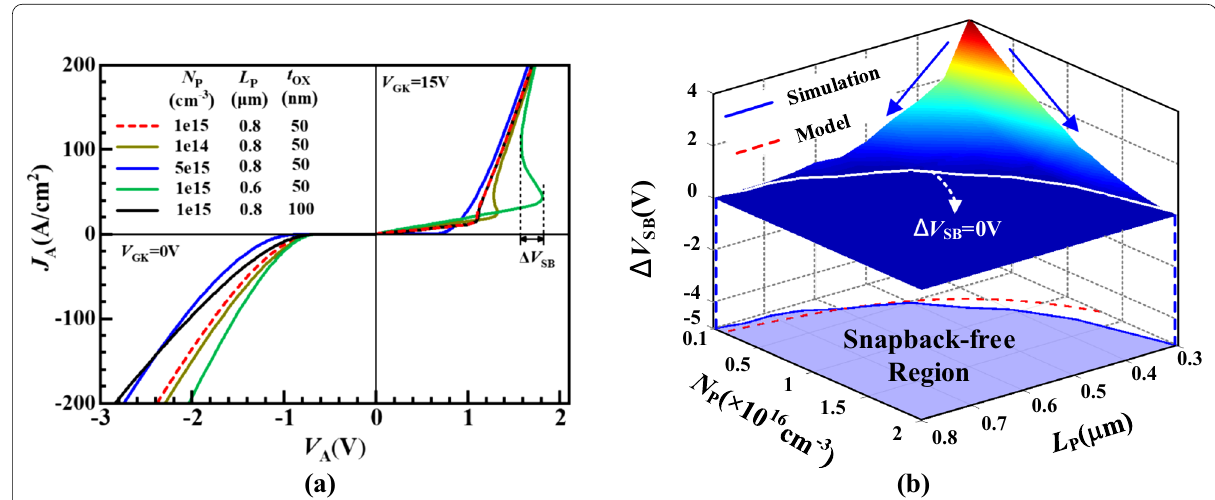
Fig. 6 a Influence of the N P , L P and t OX on conduction characteristics. b 3-D graph of influence of the N P and L P on the ∆ V